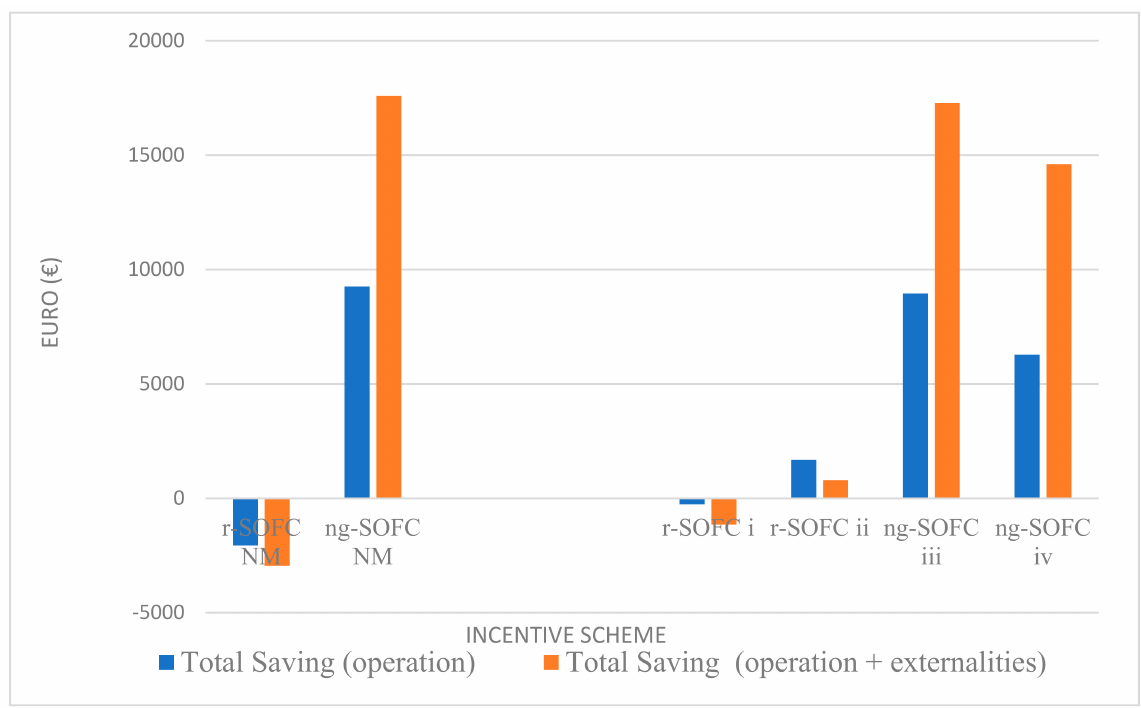
Figure 8. Comparison of total saving with and without externalities in the different incentive